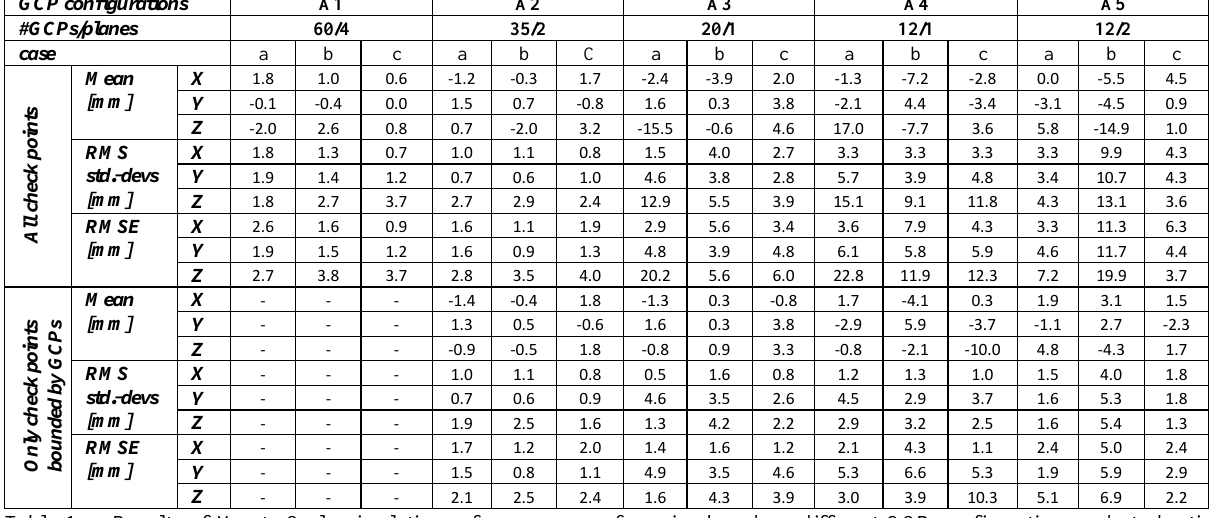
Table 1. – Results of Monte Carlo simulations of a scan geo-referencing based on different GCP configurations and stochastic models (‘a’: uniform weighting of laser scanner observations only; ‘b’: weighting laser scanner observations based on the ‘positional’ model; ‘c’: using also weights for GCPs). Results refer to the use of two different groups of check points.